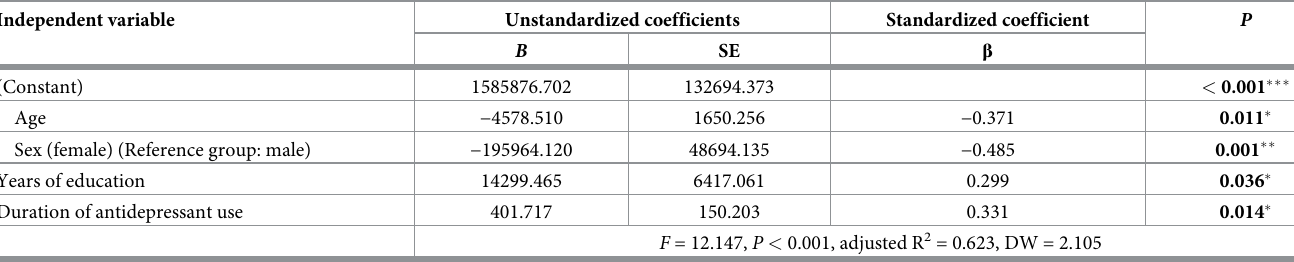
Table 4. Factors associated with whole habenula volume in the MDD